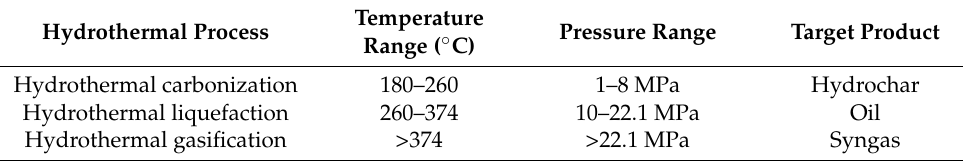
Table 2. Classification of different hydrothermal treatment processes for food waste [21]. Hydrothermal